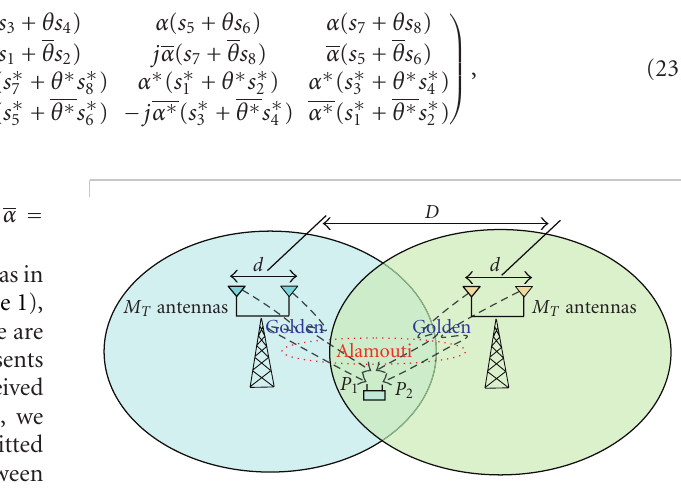
Figure 7: 3D STS scheme in SFN